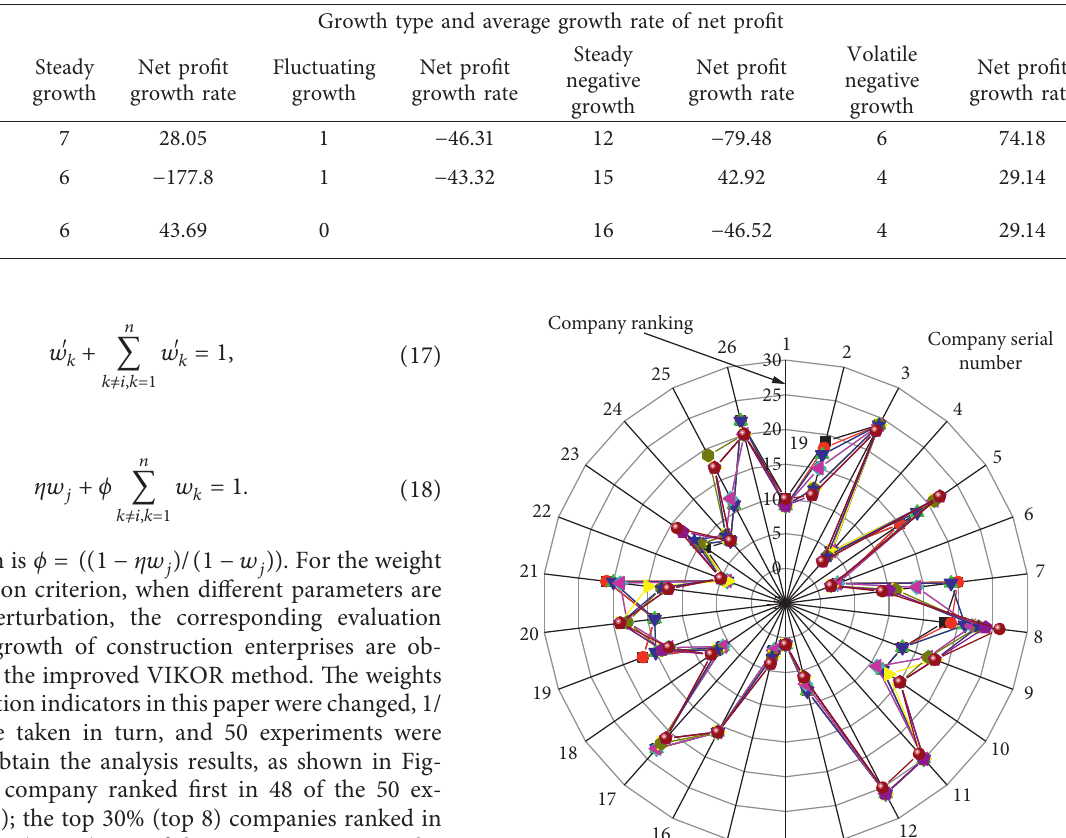
Table 8: Dynamic classification of enterprise growth in 2013–2016.